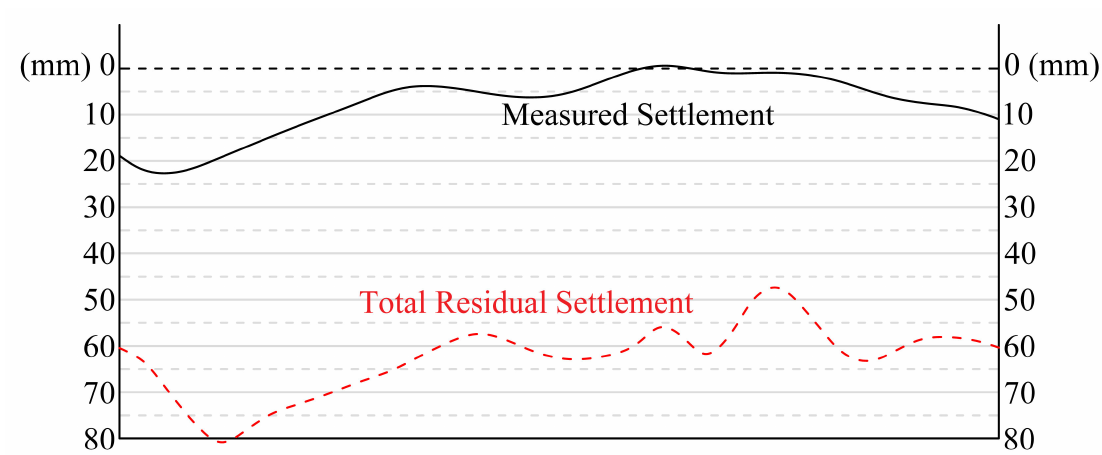
Figure 11. Contrast curve of measured settlement and total residual settlement of the tunnel